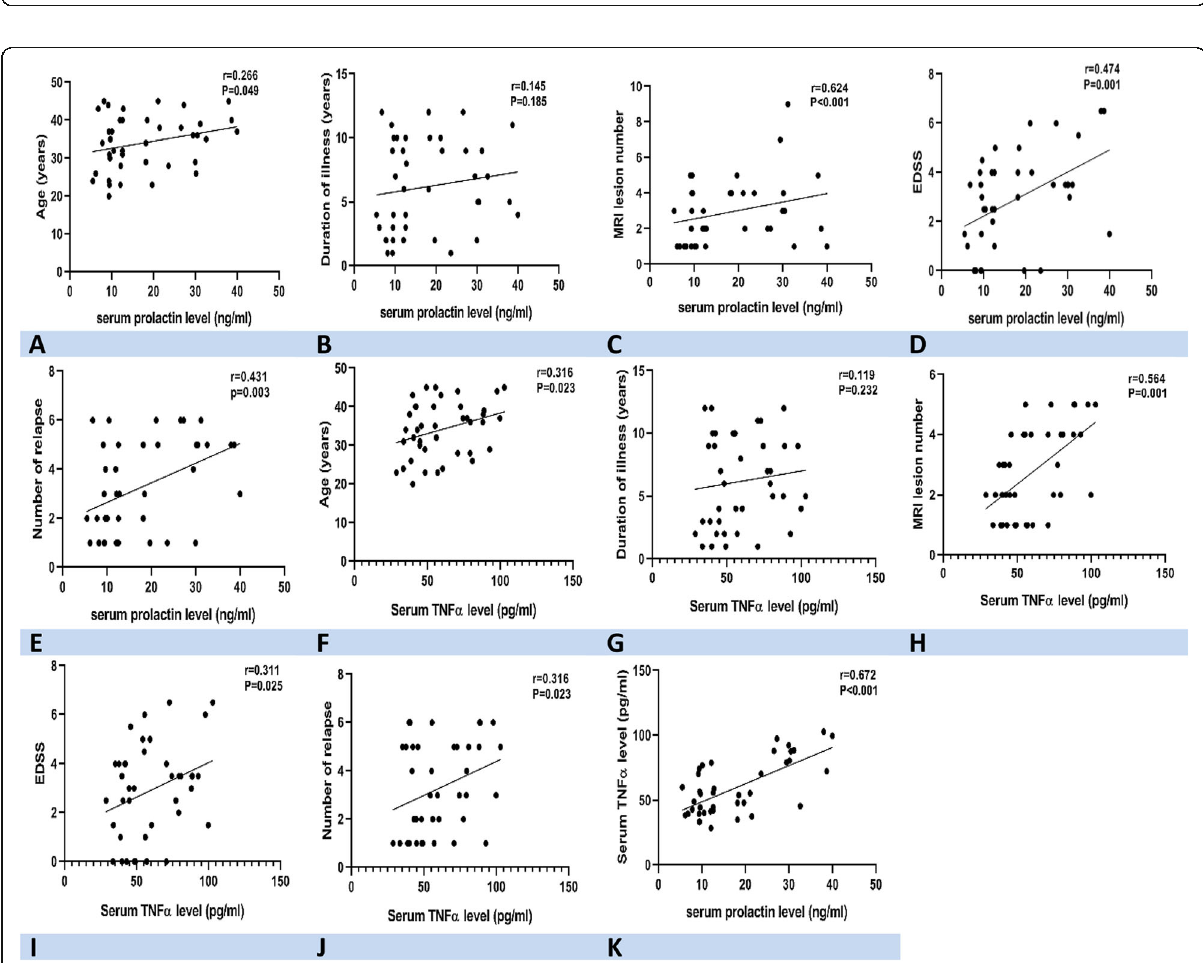
Fig. 3 AUROC analysis of the performance characteristics of serum PRL and TNF α in patients with MS relapse versus a patients with MS remission and b healthy controls